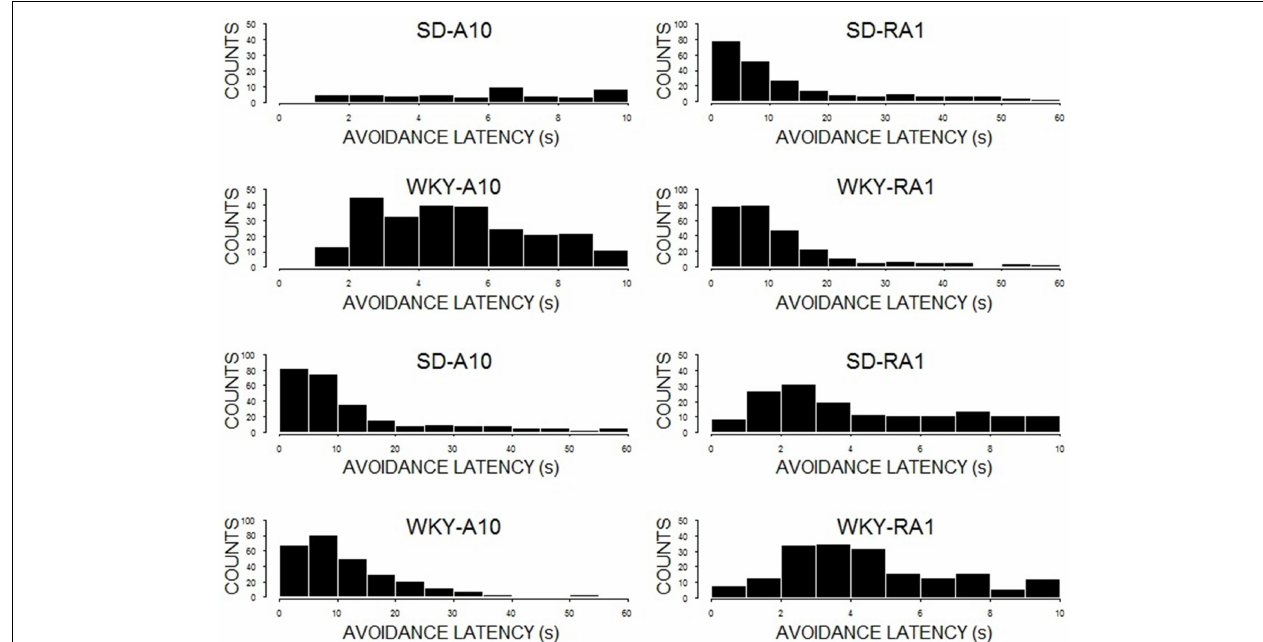
157 (RA1). The third row is WKY rats trained initially with a 10-s WS; the total count of avoidances less than 10s were 250 (A10) and 158 (RA1). The last row is WKY rats initially trained with 60-s WS; the total count of avoidances less than 10s were 148 (A10) and 185 (RA1). Note the few response in by SD rats with training with a 10-s WS (first row), with the dramatically increase of avoidance responses lower than 10s with reacquisition with a 60-s